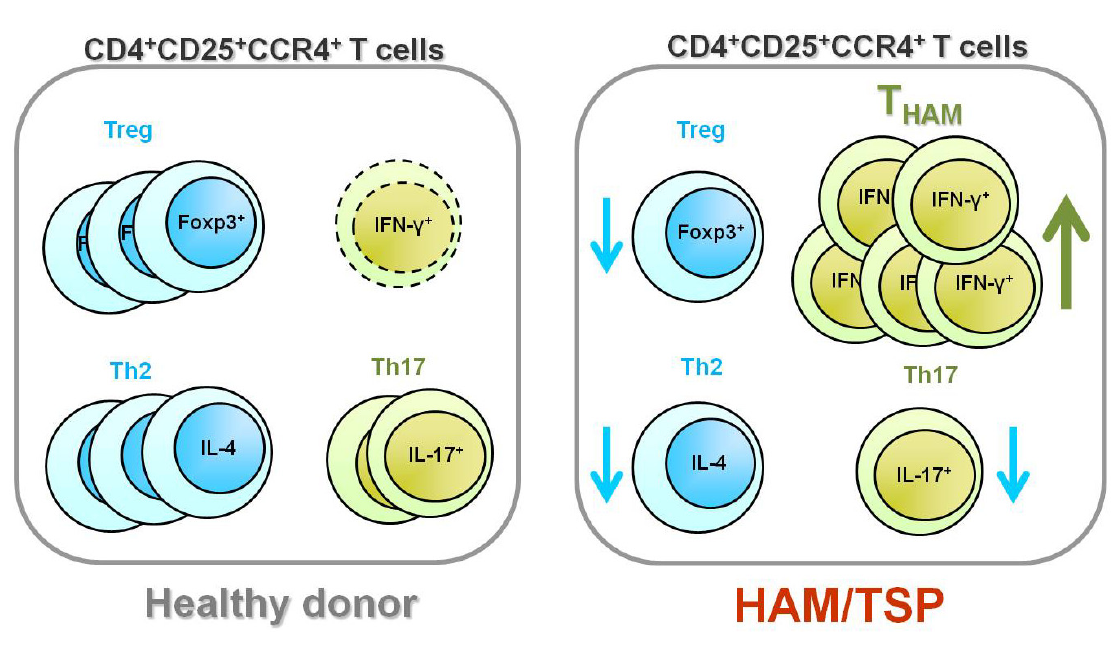
Figure 2. Cellular components of CD4 + CD25 + CCR4 + T cells in healthy donors and HAM/TSP patients. In healthy donors, the CD4 + CD25 + CCR4 + T cell